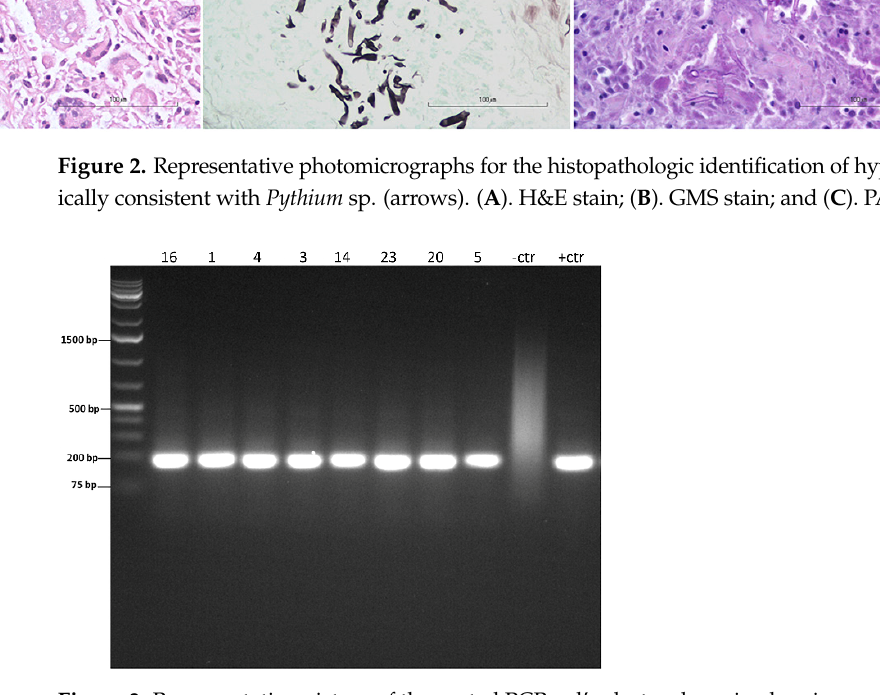
Figure 3. Representative picture of the nested PCR gel’s electrophoresis, showing positive bands with approximately 191 bp correspondent to P. insidiosum . The negative control was nuclease-free water, and the positive control was P. insidiosum DNA. DNA Ladder (L), base pair size markers; numbers refer to clinical cases; negative control (-ctr); positive control (+ctr).